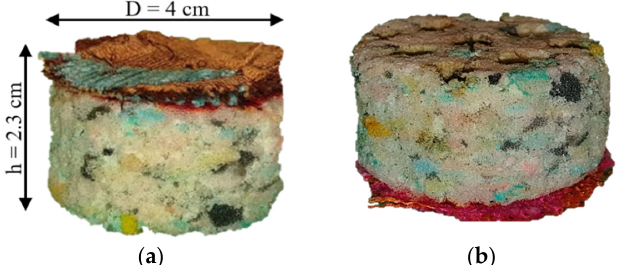
Figure 11. Two different configurations of the system perforated fabric − RPU. ( a ) T1 − RPU; ( b ) T2 − RPU.